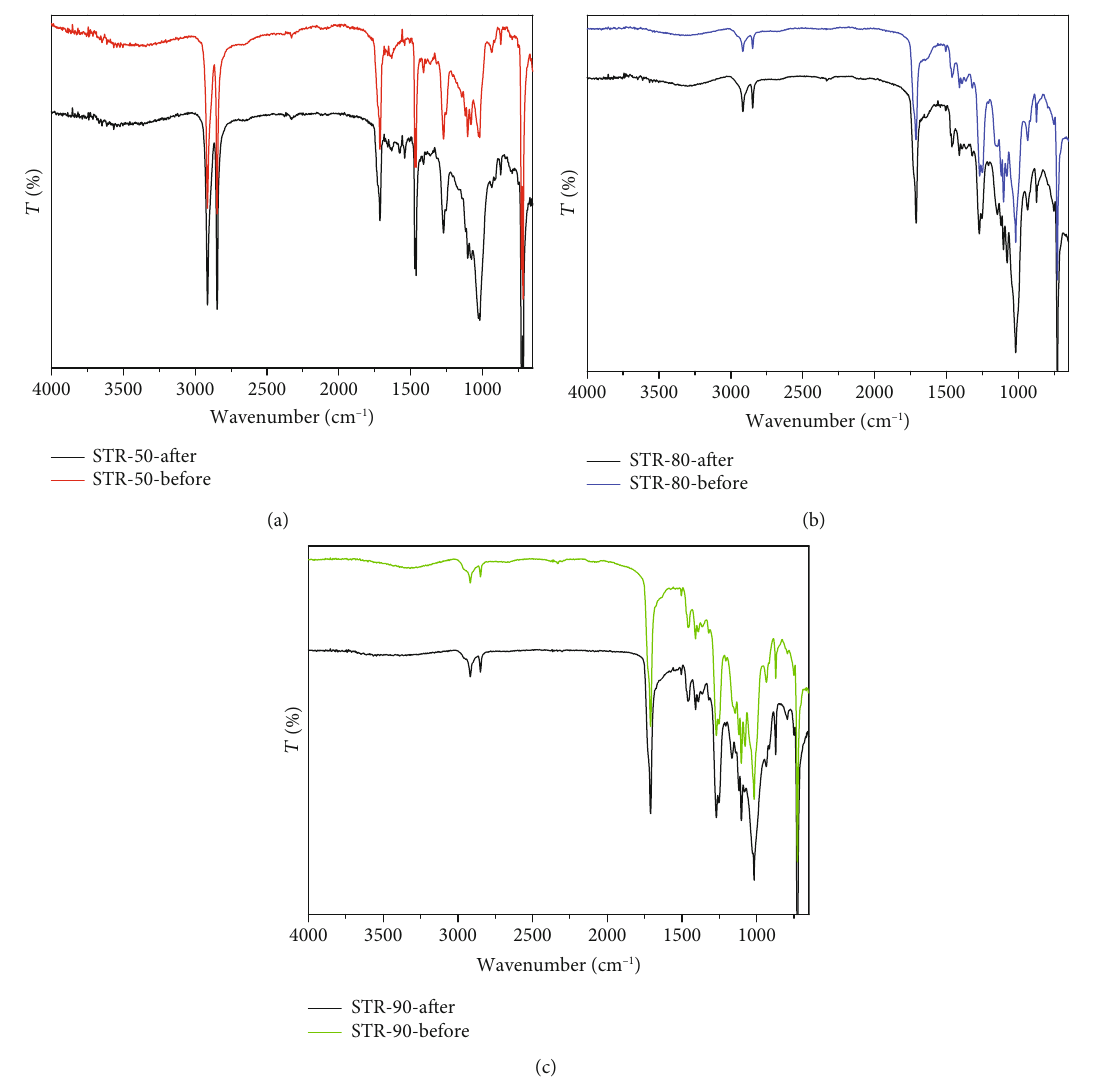
Figure 8: FT-IR spectrum of starch-based composite fi bers before and after soil biodegradation.